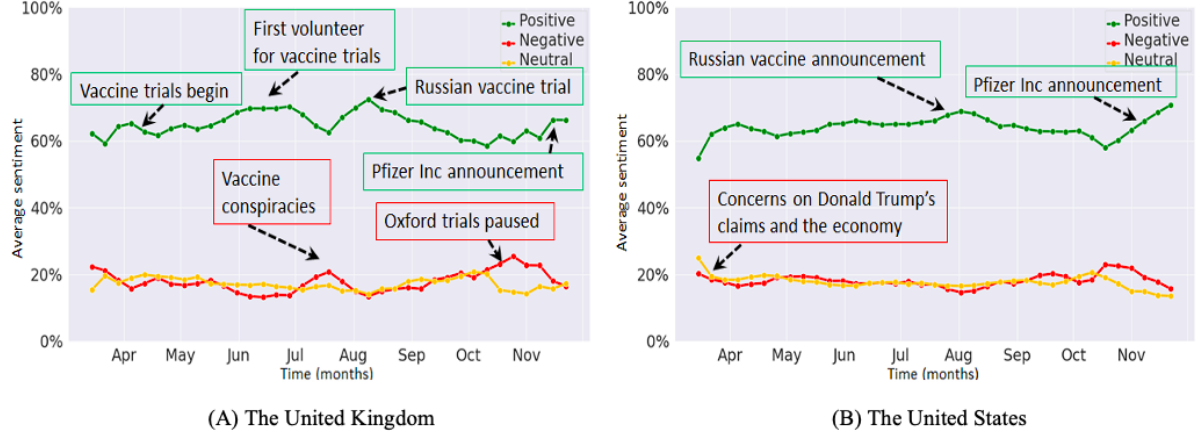
Figure 2. Averaged weekly trends in Facebook sentiments for (A) the United Kingdom and (B) the United